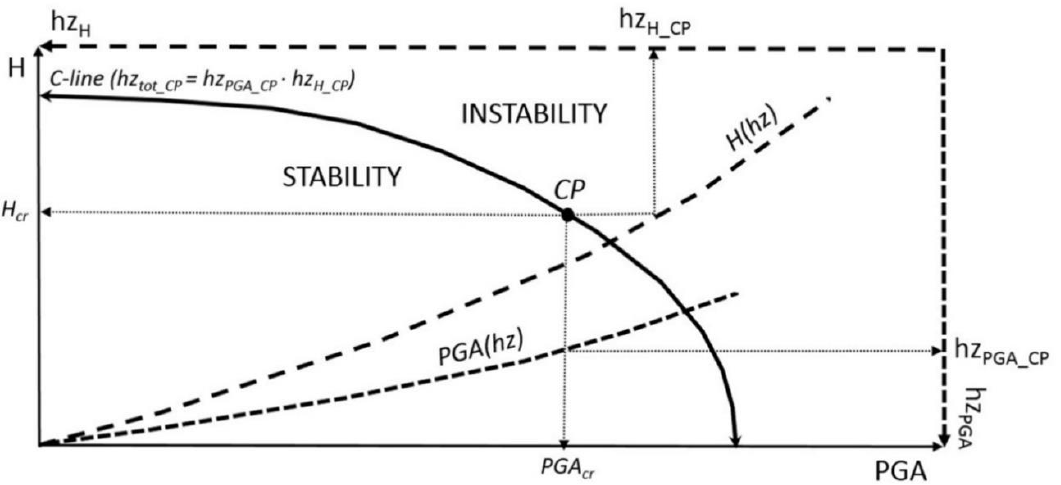
Figure 12. Conceptual stability chart.